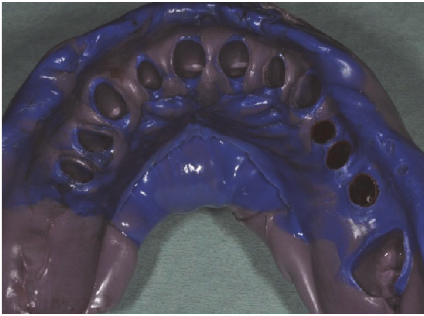
Figure 16: Superior final impression.